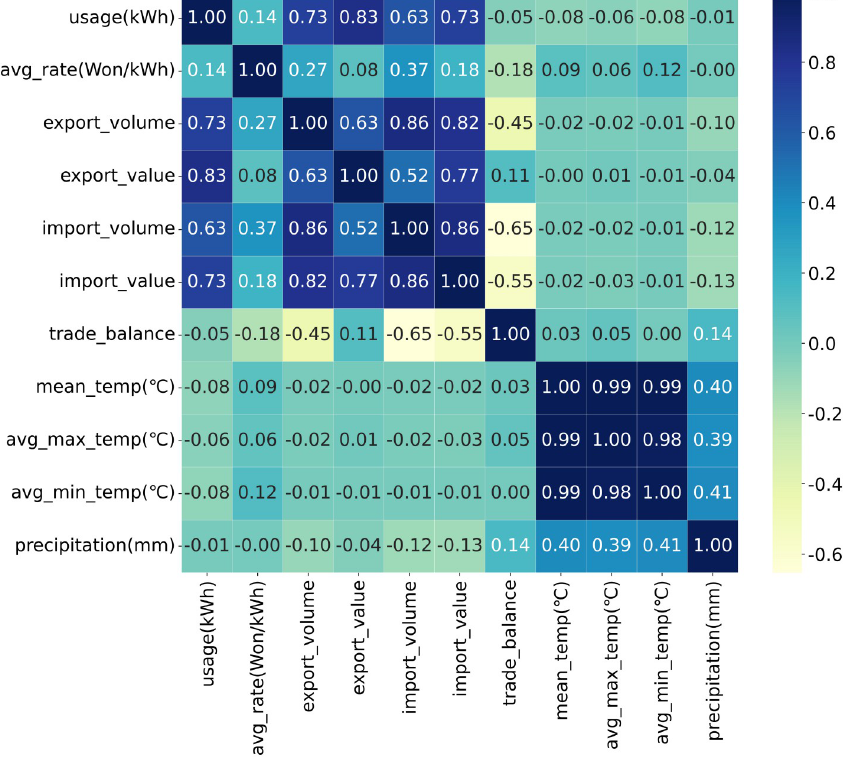
Fig 1. Correlation coefficients of input variables.